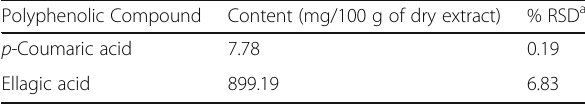
Table 1 Contents of polyphenolic compounds in P. sativum extract Polyphenolic Compound